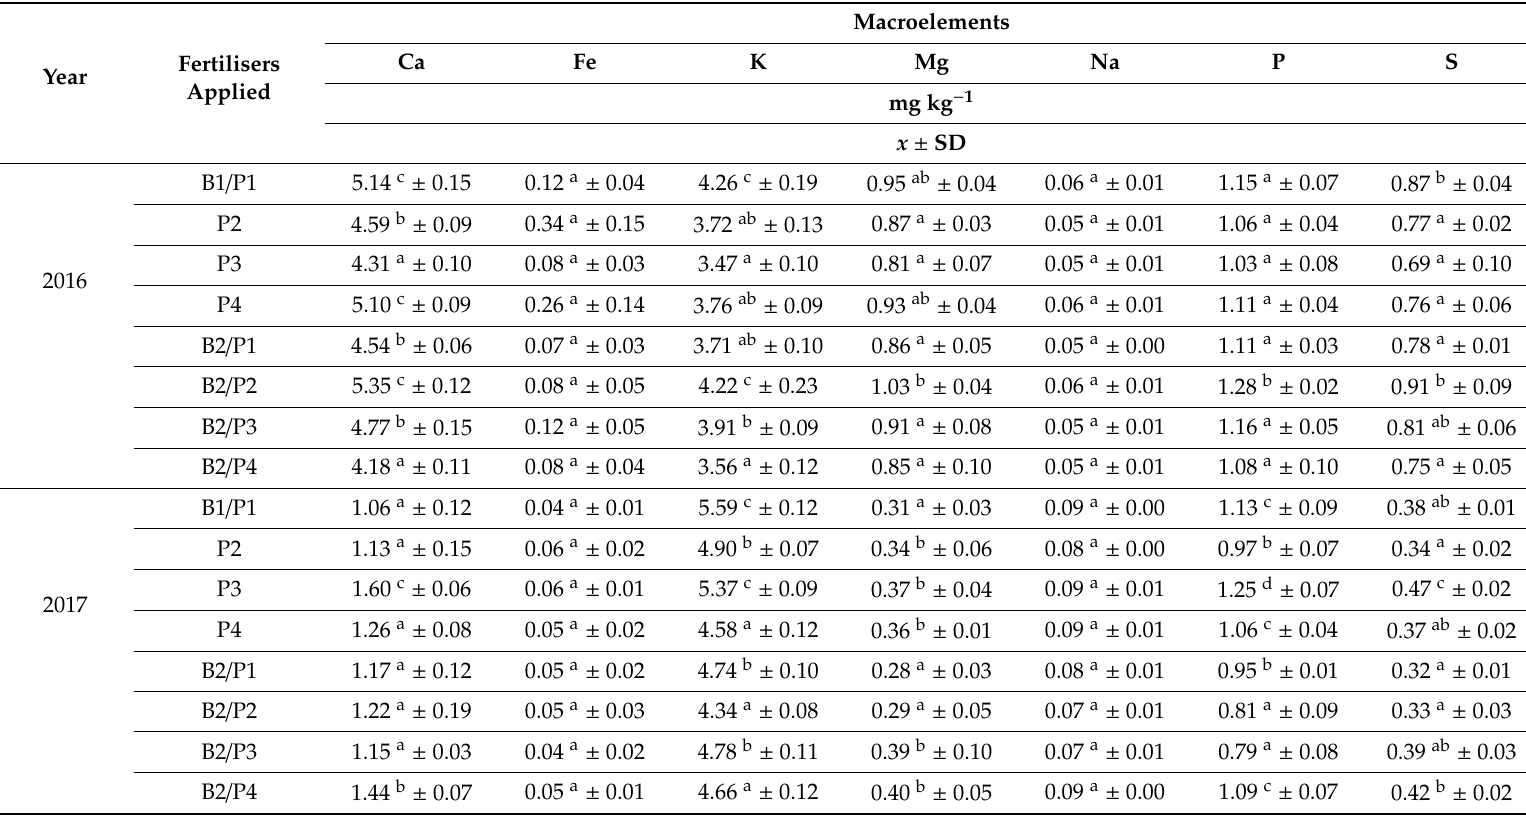
Table 7. Contents of selected macro-elements in basket willow biomass at the end of the first and the second years of cultivation in relation to the fertiliser